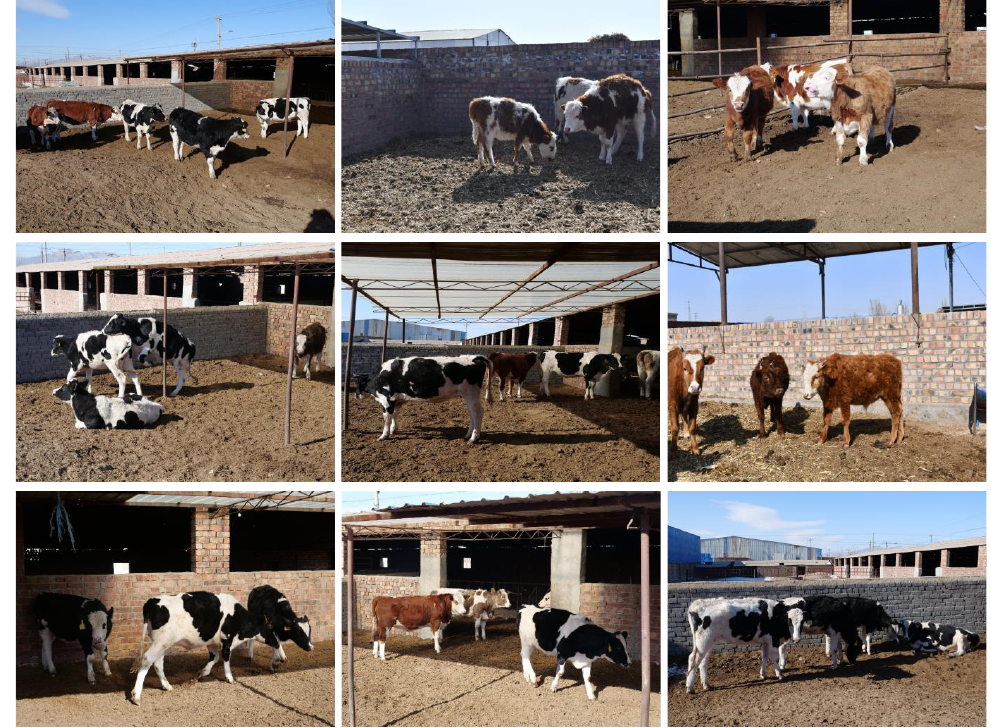
Figure 7. Real farming scenarios in the CAIDRE dataset. There are many identities such as standing, lying down, or walking. Some of them are partially obstructed by the farming structure or other animals. The breed of cattle is not limited to Simmental, but also includes Holstein Friesian cattle. Best viewed in